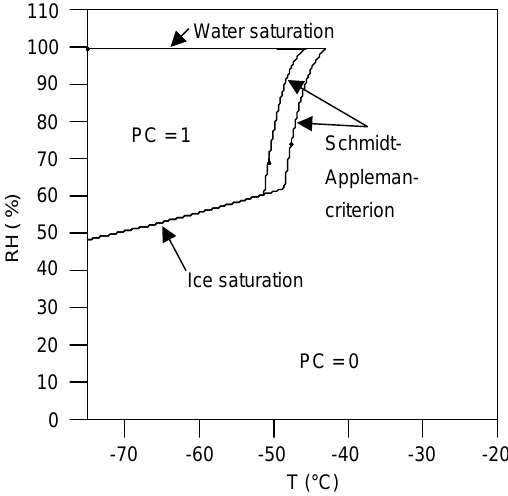
Fig. 1. For a constant pressure (as e.g. on a constant flight level) the possibility for persistent contrails development depends only on temperature and relative humidity. Persistent contrails are possible in the area indicated by PC (cid:136) 1. This area is bounded on three sides: by low RH because of the ice saturation condition, at RH (cid:136) 100% because of the water saturation condition, and at high T because of the Schmidt-Appleman criterion. The latter criterion depends on the pressure. The two boundaries are drawn for 190 ( left curve ) and 250 hPa ( right